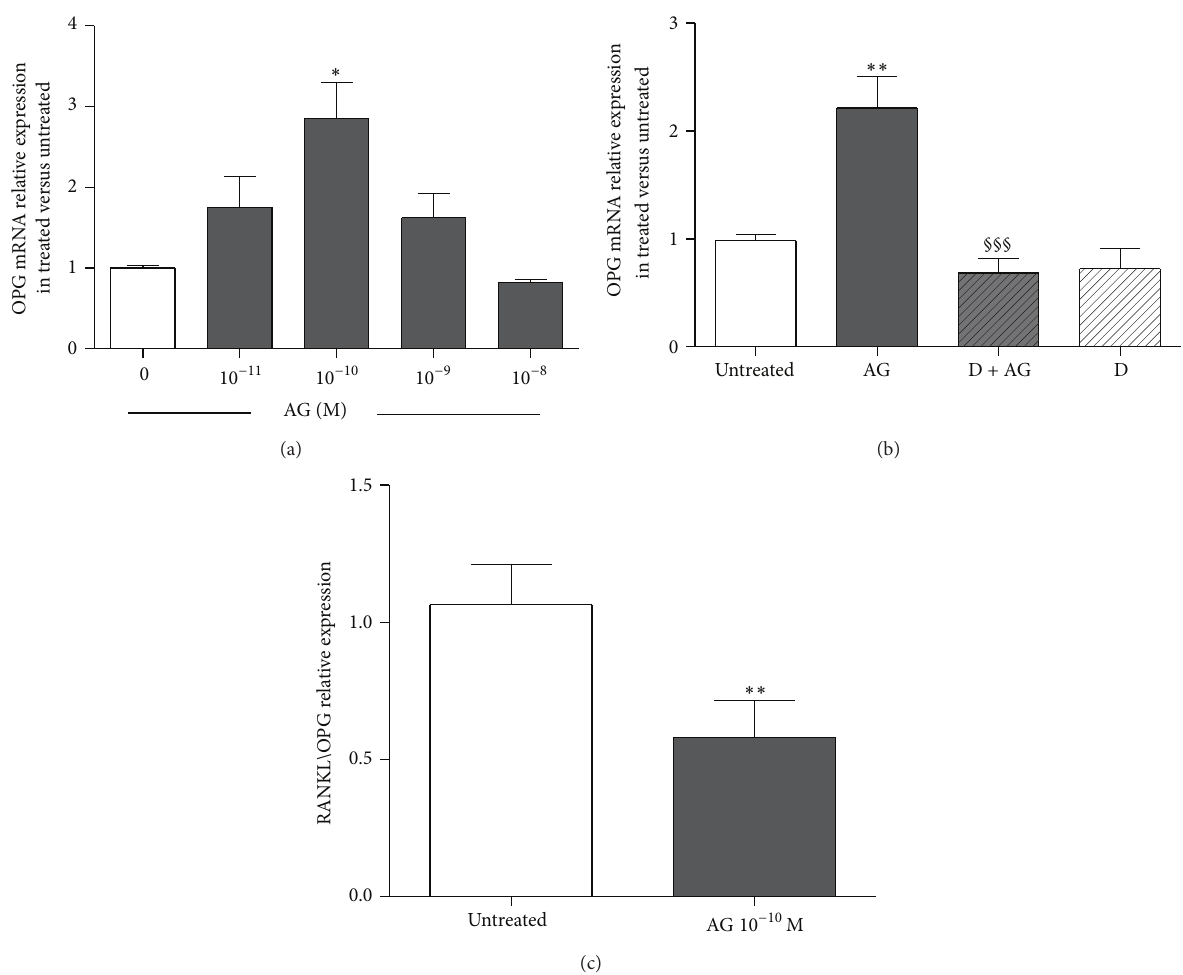
Figure 6: Effect of increasing concentrations of ghrelin (AG, 10 −11 M–10 −7 M) on osteoprotegerin (OPG) expression measured by real-time PCR at 24 h after AG treatment in primary cultures of rat osteoblast-like cells (a). Effect of pretreatment (30 min before) with the GHSR-1a antagonist D-Lys 3 -GHRP-6 (D, 10 −7 M) on the stimulatory action of AG (10 −10 M for 24 h) on OPG expression (b). Ratio of RANKL/OPG relative expression measured in untreated and AG 10 −10 M treated rat osteoblasts after 24 h (c). OPG and RANKL expression were normalized to that of GAPDH and expressed as 2 −ΔΔ Ct . Three replicates were performed for each experimental point and experiments were repeated three times. ∗ 𝑃 < 0.05 ; ∗∗ 𝑃 < 0.01 versus untreated cells. §§§ 𝑃 < 0.001 versus AG treated